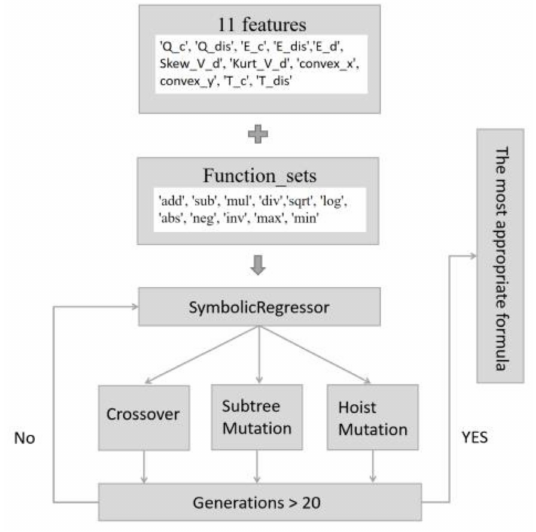
Figure 5. Structure of symbolic regression